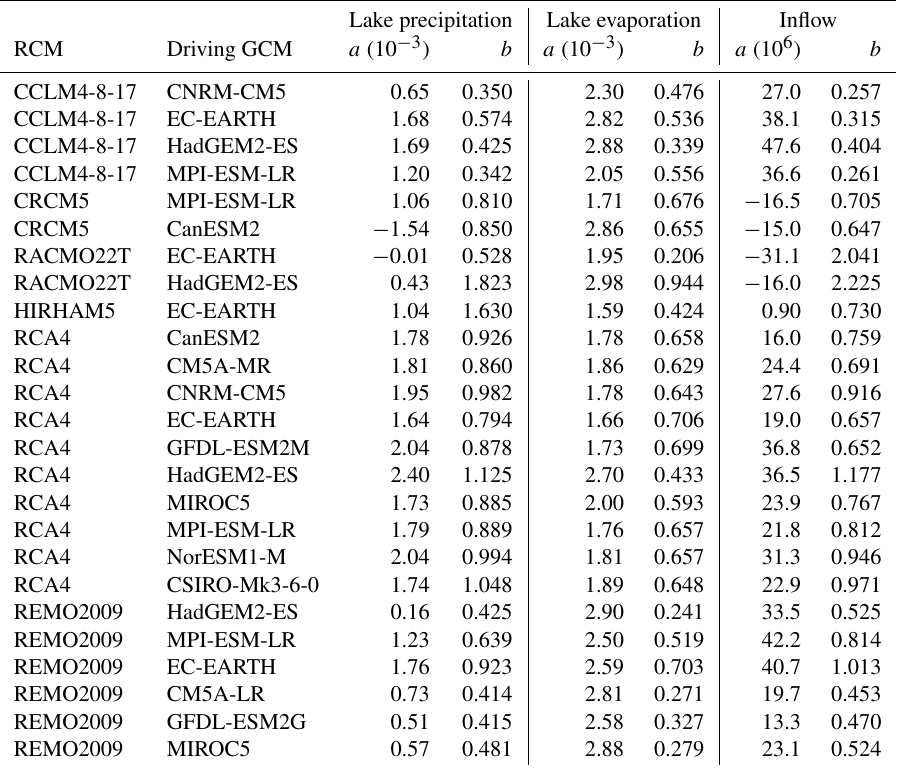
Table D1. Parameters a and b of the linear parametric transformation of the WB terms for the different CORDEX simulations (Eq.